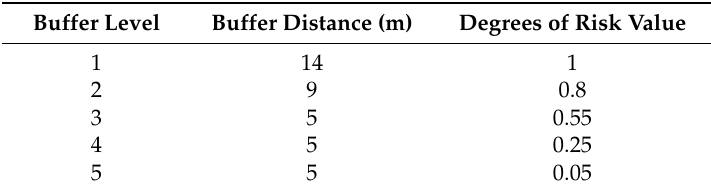
Table 1. Buffer distance and risk